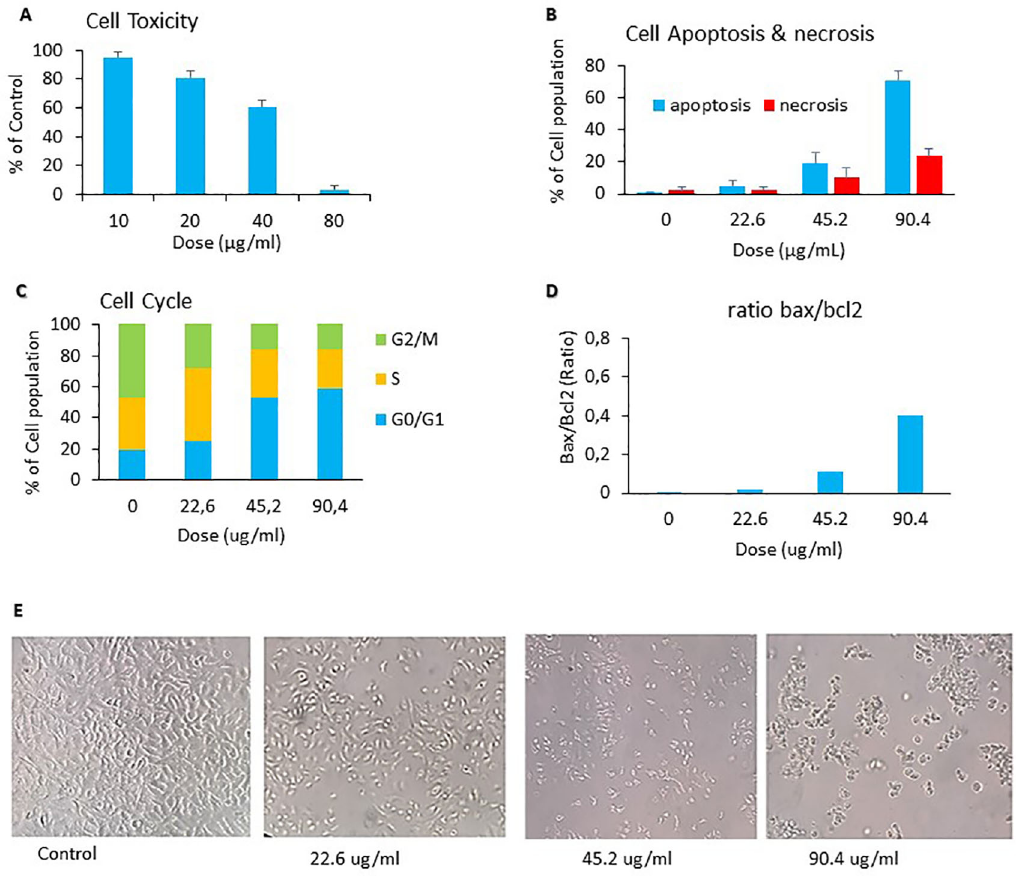
Figure 1. Anticancer activity of C. sappan against A549cells line. (A) Cytotoxicity assay;(B) apoptosisassay;(C) cell cycle assay; (D) BAX-BCL-2 assay; (E) cell morphology